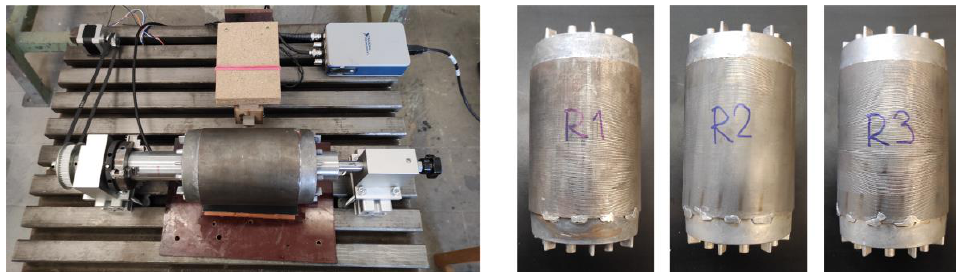
Figure 24. Measurement system for real rotor testing.